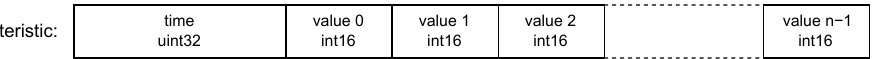
Figure 10. Encoding of ECG characteristics.